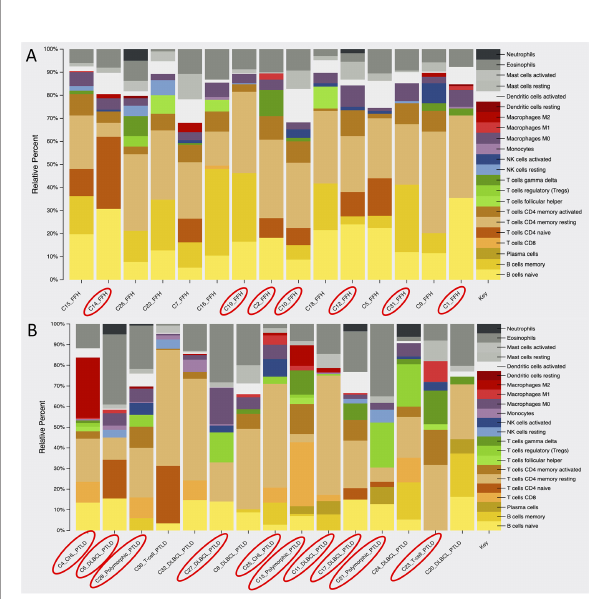
FIGURE 5 | Enrichment analysis for promoter region, promoter fl anking regions, and transcription binding sites (CTCF). The top part of the fi gure shows the observed versus expected number of mutations. In the bottom part of the fi gure, the mutational burden within the same non-coding gene regions for both groups are demonstrated as the log2 ratio of the number of observed and expected point mutations indicating the effect size of the enrichment or depletion within each region. (*) = statistical signi fi cance (p<0.05; two ‐ sided binomial test).